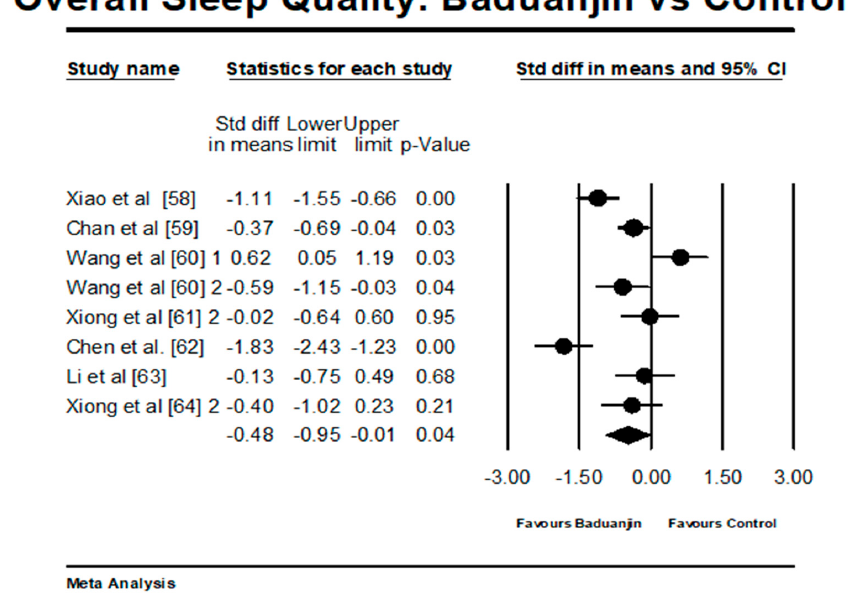
Figure 5. Effect of Baduanjin on overall sleep quality (without including two outliers); Wang et al. [60] 1 = Baduanjin vs. LiuZijue; Wang et al. [60] 2 = Baduanjin vs. no training; Xiong et al. [61] 2 = Baduanjin vs. acupuncture; Xiong et al. [64] 2 = Baduanjin vs. acupuncture). 1 is referring to the first comparison, which is Baduanjin vs. Liuzijue; 2 for the second comparison in the same study.